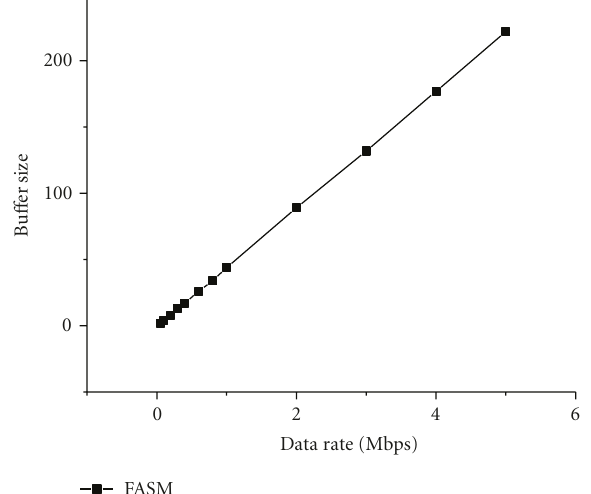
Figure 15: Relationship between the RTP data rate and the NAR’s bu ff er